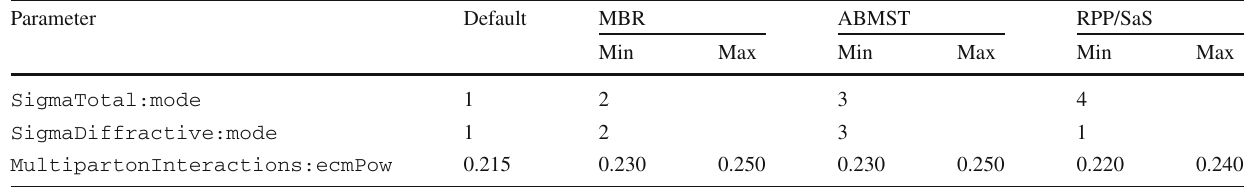
Table 2 Table showing the values of changed parameters relative to the default Monash2013 tune of Pythia 8.2 in variants where the modelling of the total, elastic and diffractive cross sections has been changed Parameter